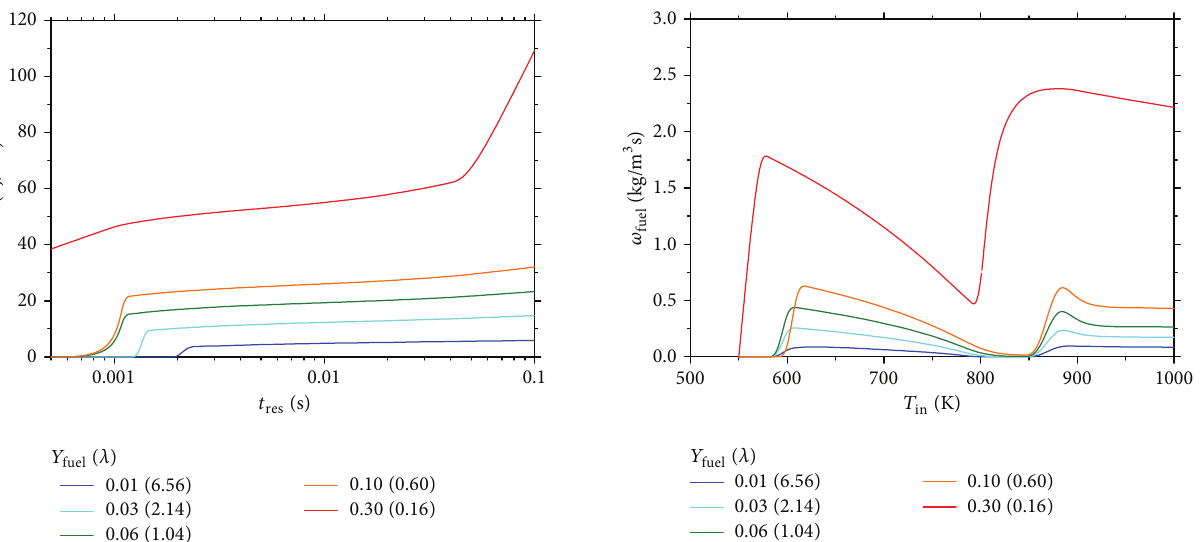
Figure4:Predictionsofheatreleaseperunitvolumeasafunctionof residence time for 5 characteristic values of fuel concentration ( 𝑇 = 740 K).